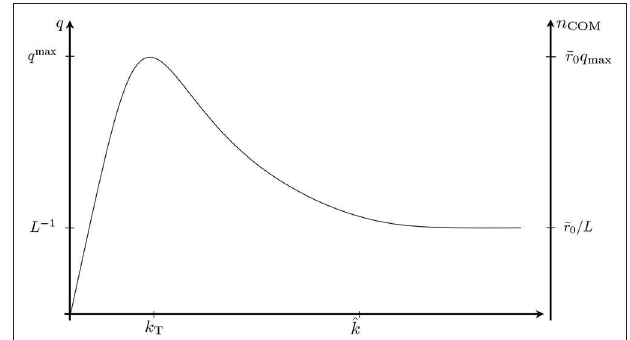
r 0 q ( k ) = ¯ 0 = L − 1 /3 0 const, with L √ λ = = ≡ ∗